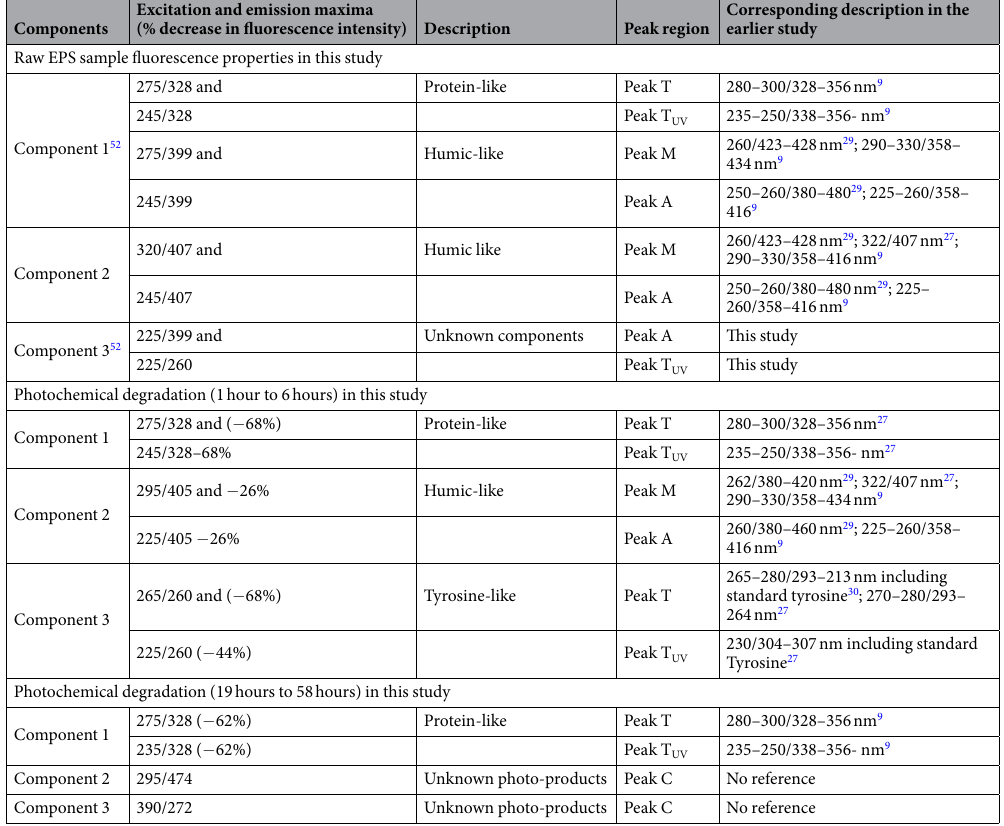
Table 1. Fluorescence excitation/emission (Ex/Em) wavelengths of the raw and treated EPS and the subsequent characteristic peaks of the reference components. ( + ) and ( − ): an increase and a decrease in fluorescence intensities (%) of various peaks, respectively due to solar and microbial effects. The percentage changes in the fluorescence intensities of various components are estimated by comparing the treated samples with raw EPS samples (before irradiation). Only daylight exposure hours (12 hours per day) were counted, to the exclusion of night